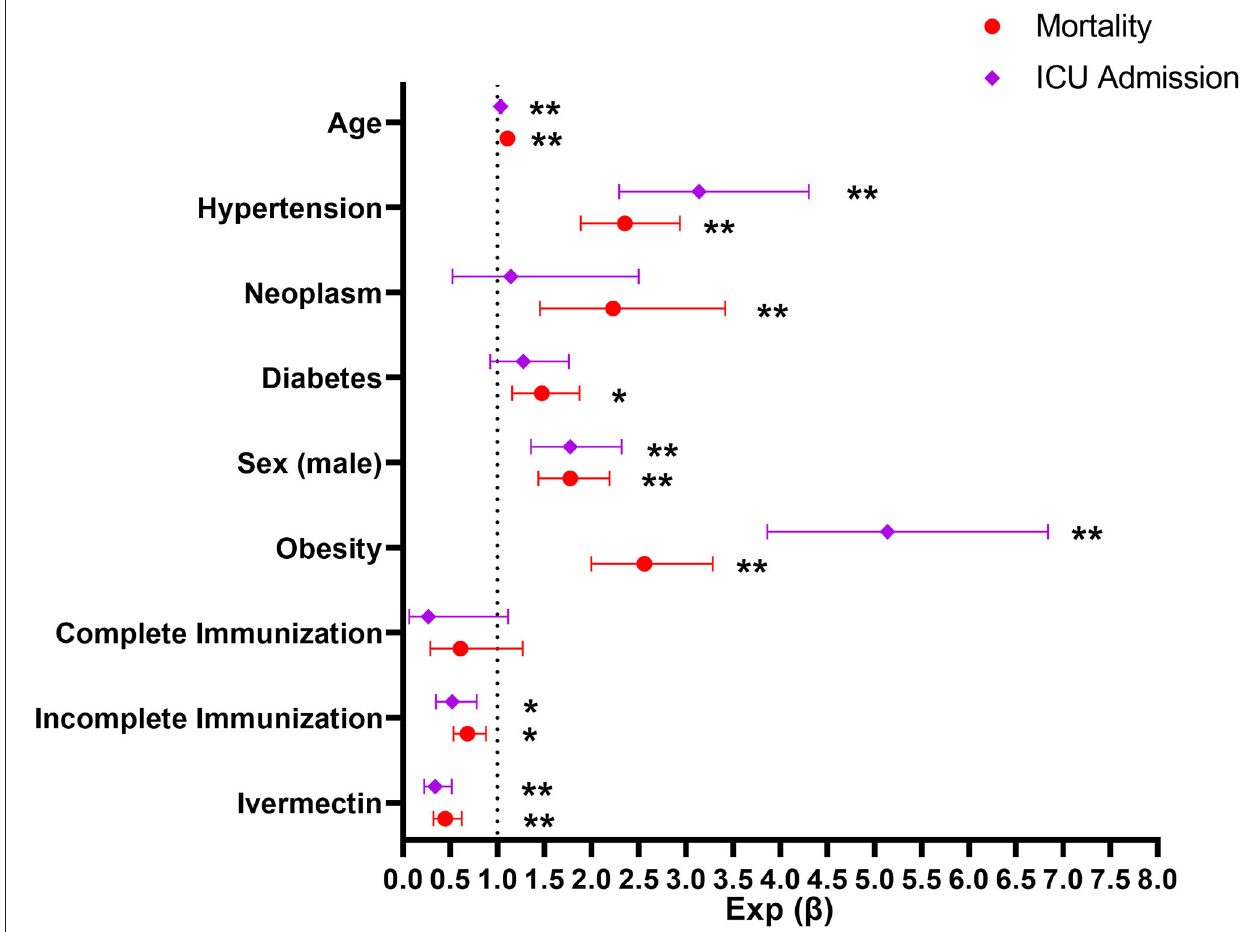
FIGURE 3 | ICU admission and mortality in patients receiving ivermectin within MEURI program vs. Control after controlling for other variables by multiple logistic regression analysis. Age was considered as a continuous variable. Subjects were considered immunized after 14 days of their last vaccine dose. ** p < 0.001; * p <